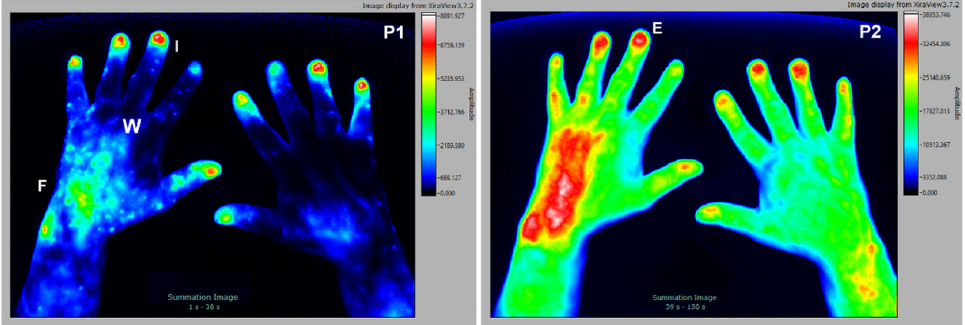
Figure 6. The 68 y/o male patient with clinical diagnosis Lyme borreliosis. Punctual (F) and cloudy (W) signals and irregular dye flow in the fingertips (I) can be seen during P1, with slight accumulation of the dye in the entheses and tendons (E), seen during P2.